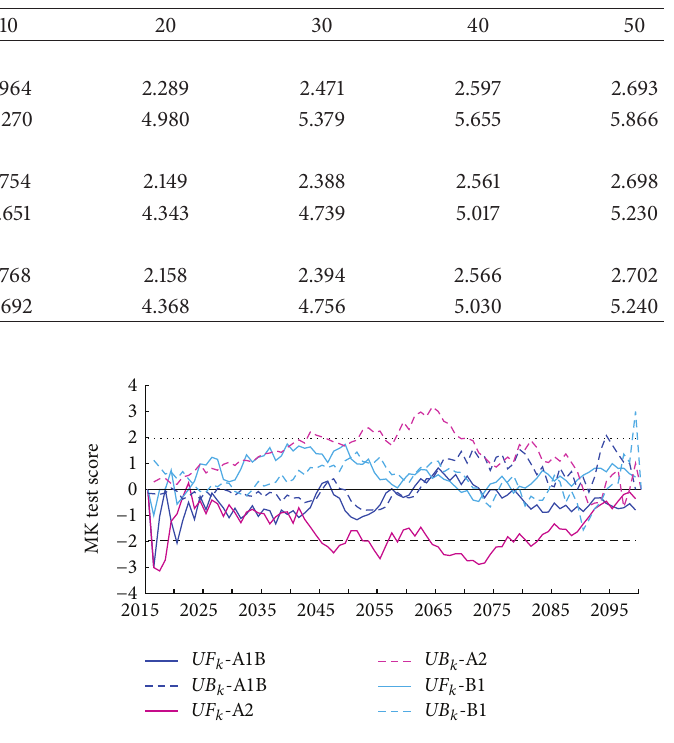
Figure 8: MK test score for annual precipitation from 2016 to 2100 under three climate change